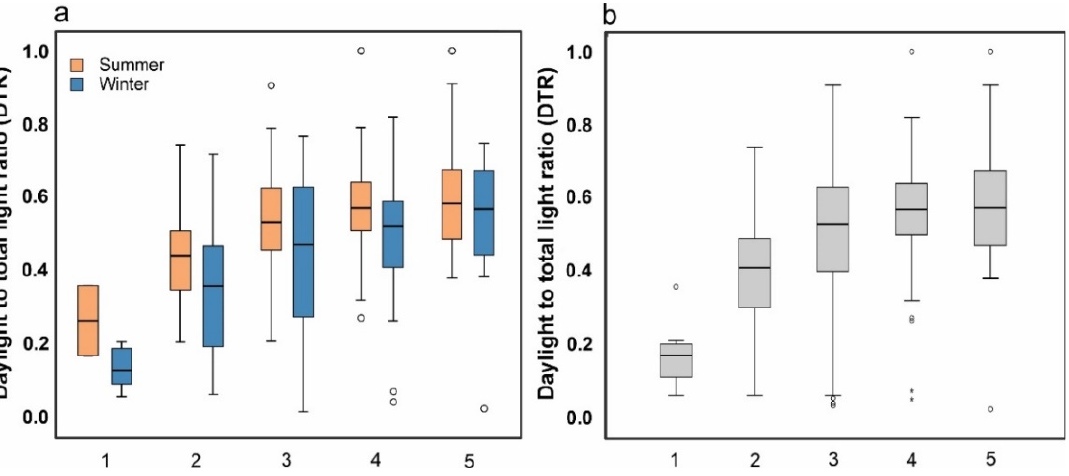
Figure 6. DTR satisfaction. Separated by season ( a ) in general ( b ). Note: For graph 1–5, 1 = very unpleasant, 2 = unpleasant, 3 = neutral, 4 = pleasant, 5 = very pleasant. Extreme outliers are marked with an asterisk and circles.